Question: Describe this figure in one sentence.
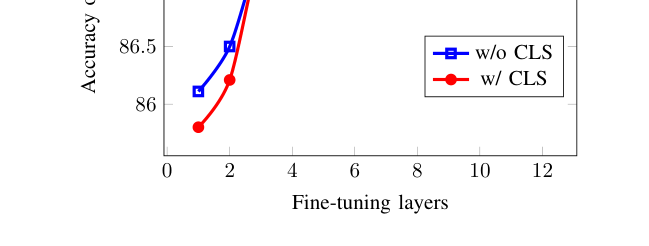
Answer: Comparison on 5-way 5-shot performance with the model under different fine-tuning layers on miniImageNet. ViT-Small is the backbone. ’w/o CLS’ denotes fine-tuning excluding CLS and ’w/ CLS’ denotes fine- tuning including CLS.